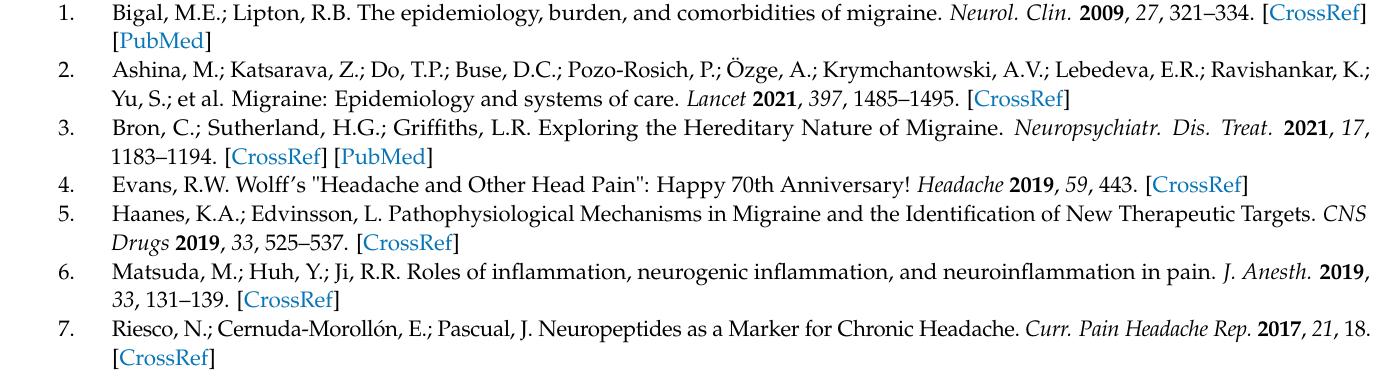
Table S2: Summary of pathological changes in the Brain/Spinal cord, Table S3: Summary of pathological changes in the